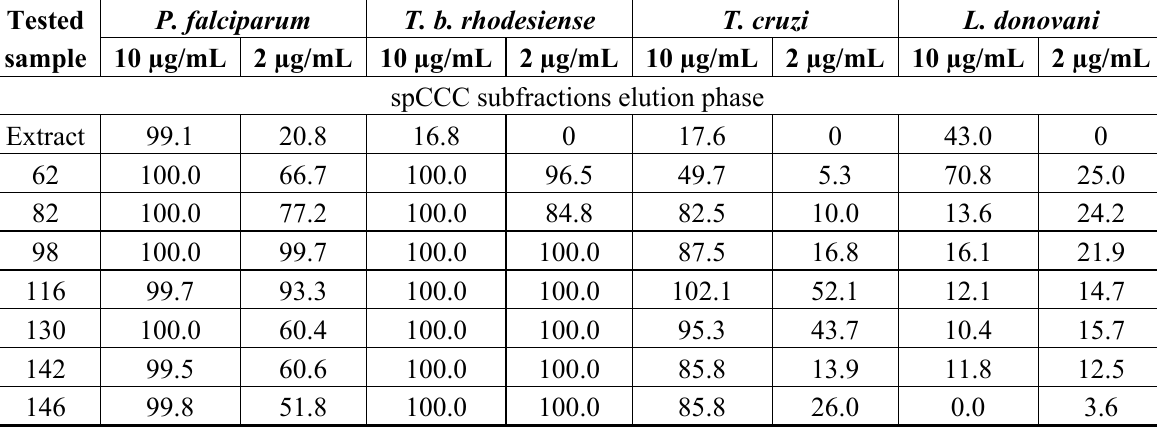
Table A1. In vitro growth inhibition [%] of B. sempervirens leaf extract and representative spiral-coil countercurrent chromatography (spCCC) subfractions of the alkaloid fraction. Each entry represents the mean of two independent